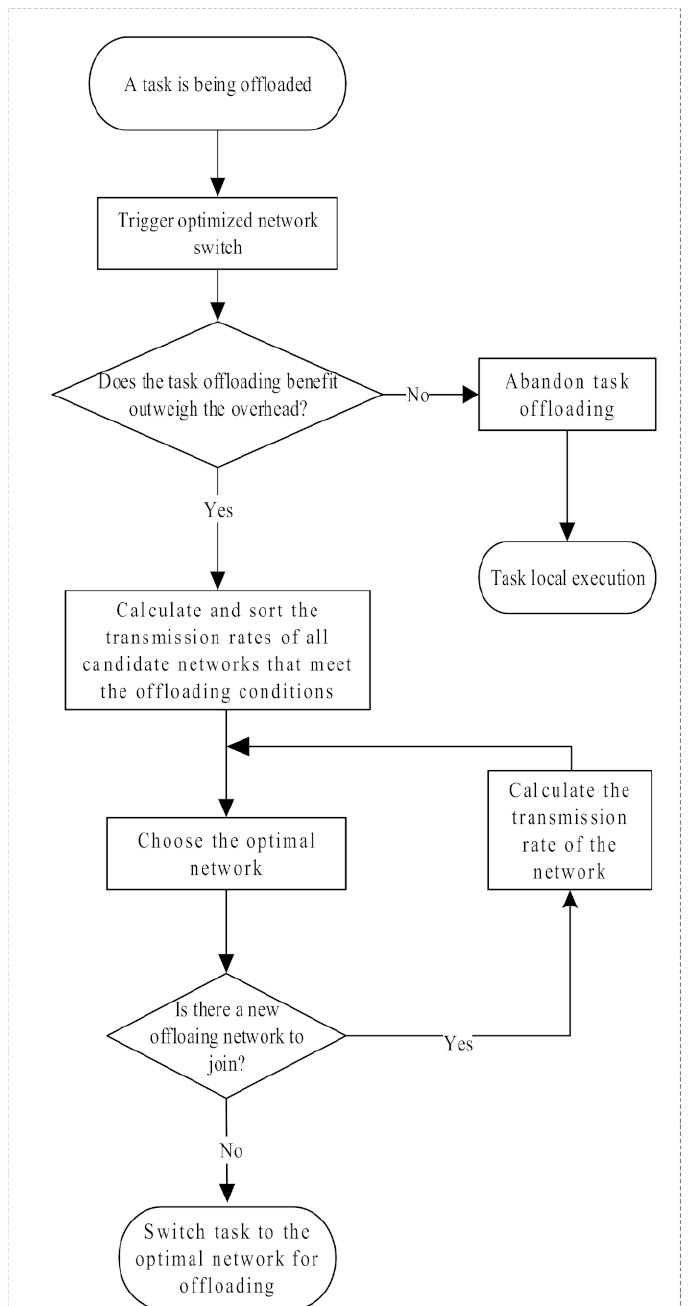
Figure 3. Network Switching Flowchart. This figure represents the network selection and switching process during task offloading. Network switching is always present during the whole task offloading process, always keeping the network where the current task is offloaded as the optimal network, so that the delay and energy cost of task offloading are